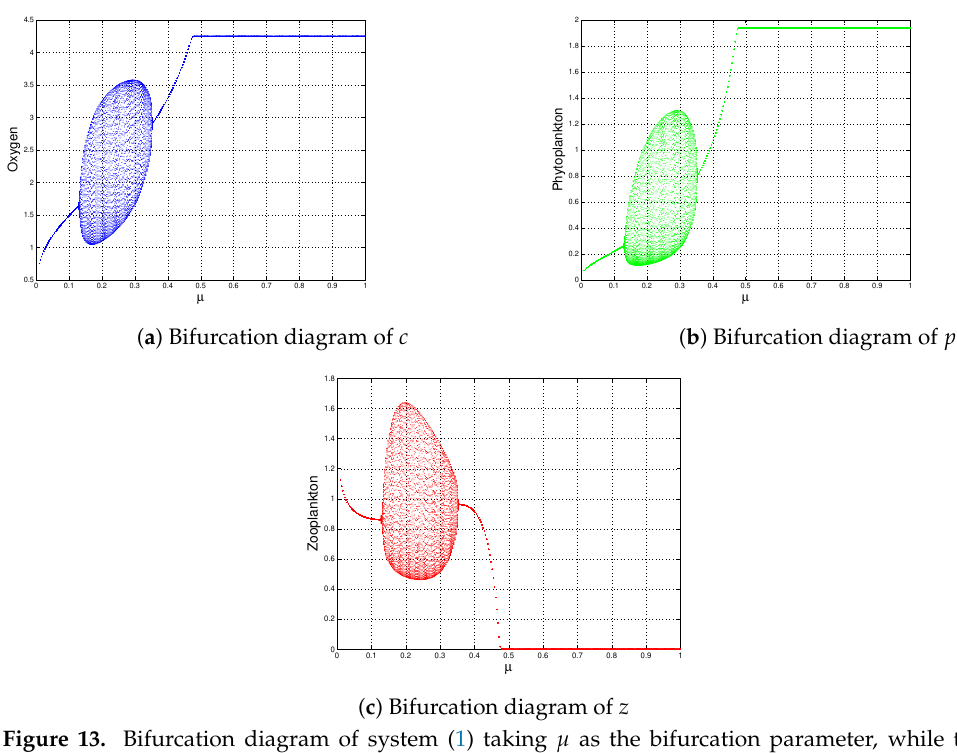
Figure 13. Bifurcation diagram of system (1) taking µ as the bifurcation parameter, while the others remain unchanged, as in Figure 6. (cid:98) E ( (cid:98) c , (cid:98) p , (cid:98) z ) is unstable with a periodic solution when µ ∈ ( µ [ H ] 1 = 0.131580, µ [ H ] 2 = 0.354676 ) and stable when µ ∈ ( 0,0.131580 ) ∪ ( 0.354676,0.474246 ) . Again, (cid:98) E ( (cid:98) c , (cid:98) p , (cid:98) z ) goes to stable zooplankton free equilibrium E 1 ( (cid:101) c , (cid:101) p ,0 ) when µ > µ [ tc ] = 0.474246.